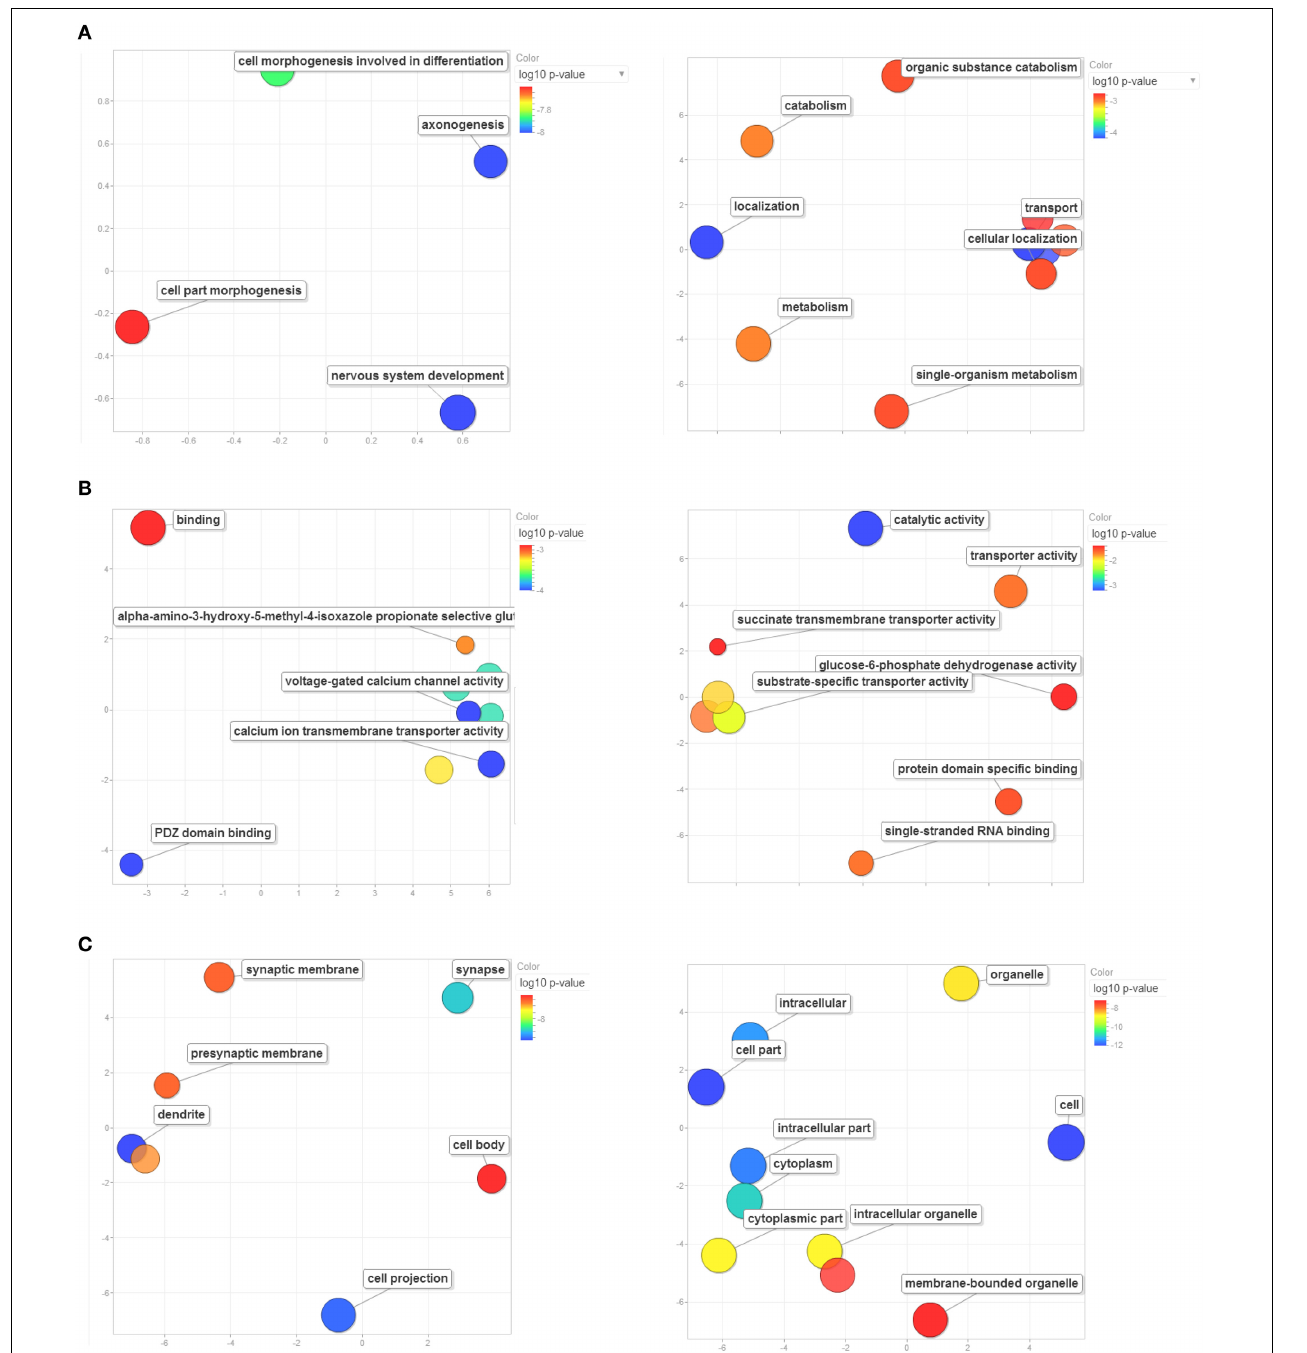
FIGURE 7 | Enrichment analysis based on GO terms for Master PC1’s (left column) and Master PC2’s (right column) top-500 correlated gene set. Significant enrichment of genes included in GO terms relevant to (A) biological processes, (B) molecular functions, and (C) cellular components. Only significantly enriched GO categories are depicted. Bubbles are color-coded according to the adjusted log 10 p -value of the top-correlated genes enrichment relative to the whole mouse genome. Blue and green bubbles are GO terms with more significant p -values than the orange and red bubbles. The bubbles’ x